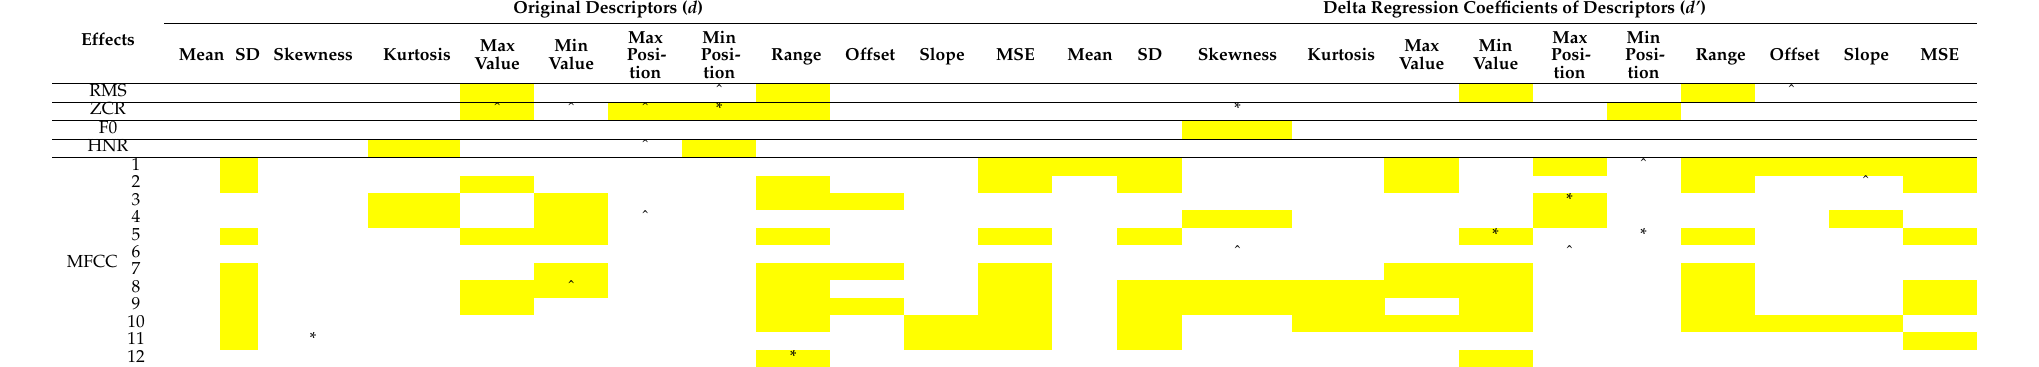
Table 2. Screened voice features using ANOVA and correlation from 384 voice features produced by